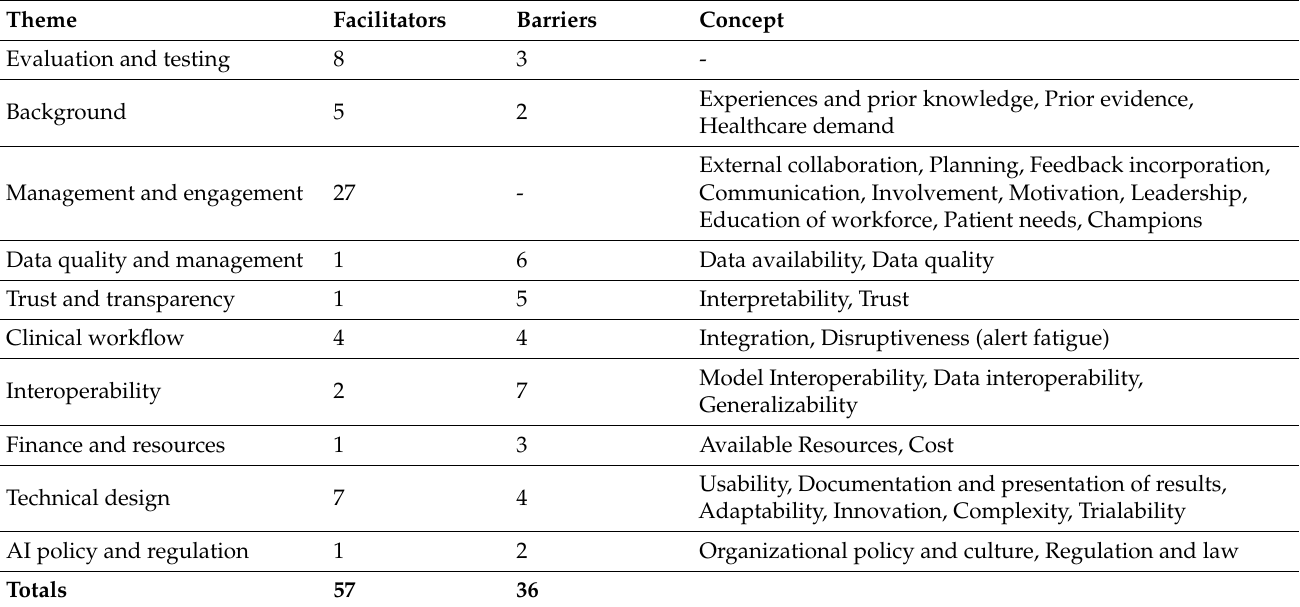
Table 4. Inductive extraction of concepts and themes.